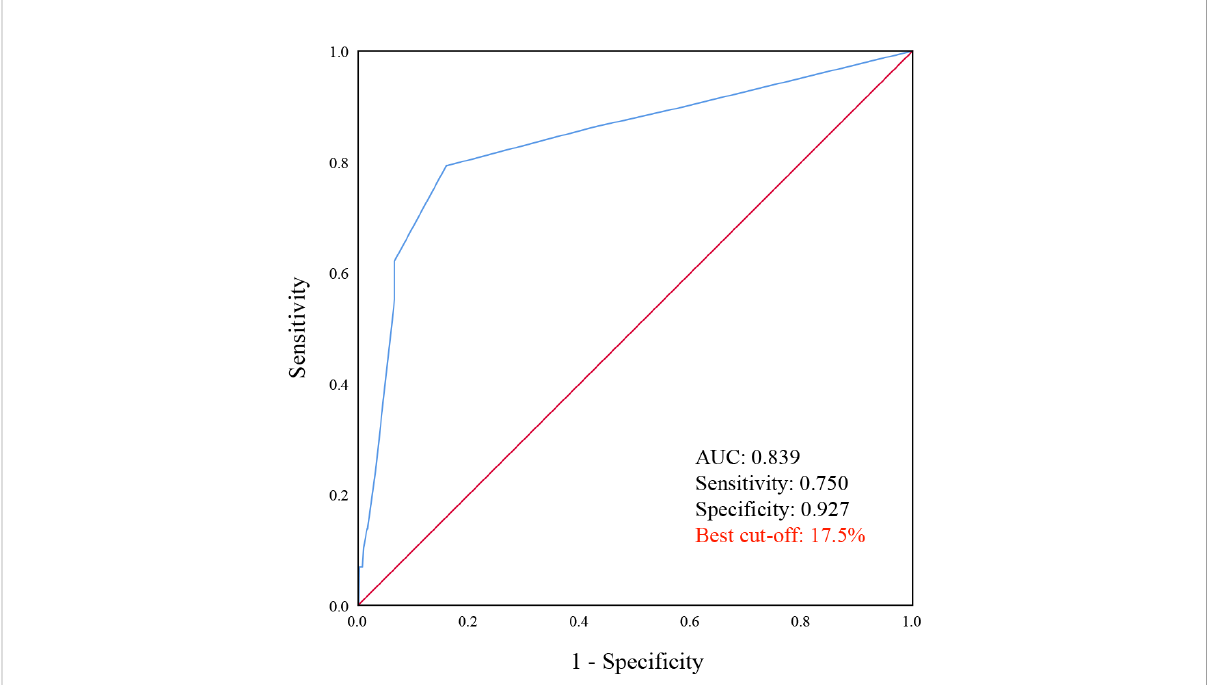
FIGURE 4 ROC curve of high-grade patterns for lymph node metastasis using local data. A cutoff of 17.5% for high-grade patterns was the value that offered the best combination of sensitivity and speci fi city of the curve (0.75 and 0.927, respectively), resulting in AUC of 0.839 for lymph node